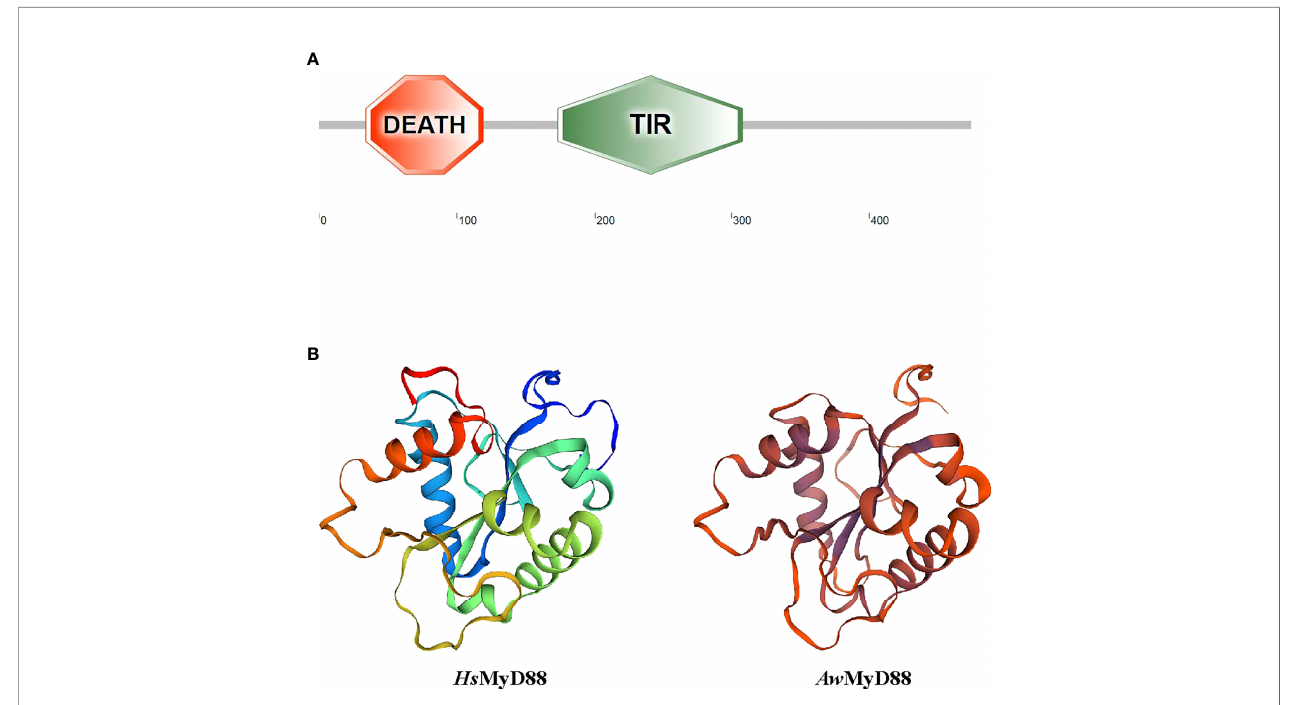
FIGURE 1 | Domain organization and three-dimensional structure of Aw MyD88. (A) Domain analysis of Aw MyD88 was performed using the SMART tool. (B) Tertiary structures of Hs MyD88 and Aw MyD88 were predicted by the SWISS-MODEL